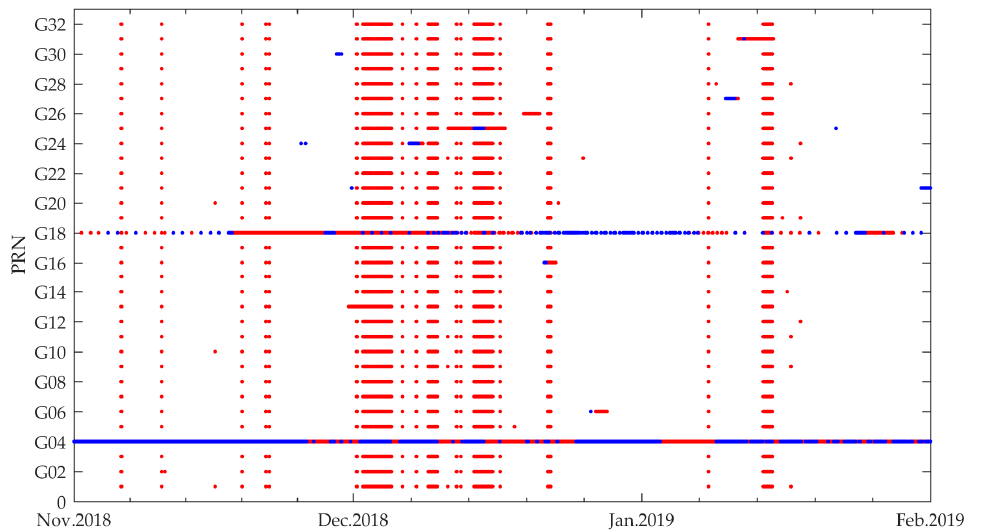
Figure 2. Unavailability of MADOCA real-time products for GPS satellites from 1 November 2018